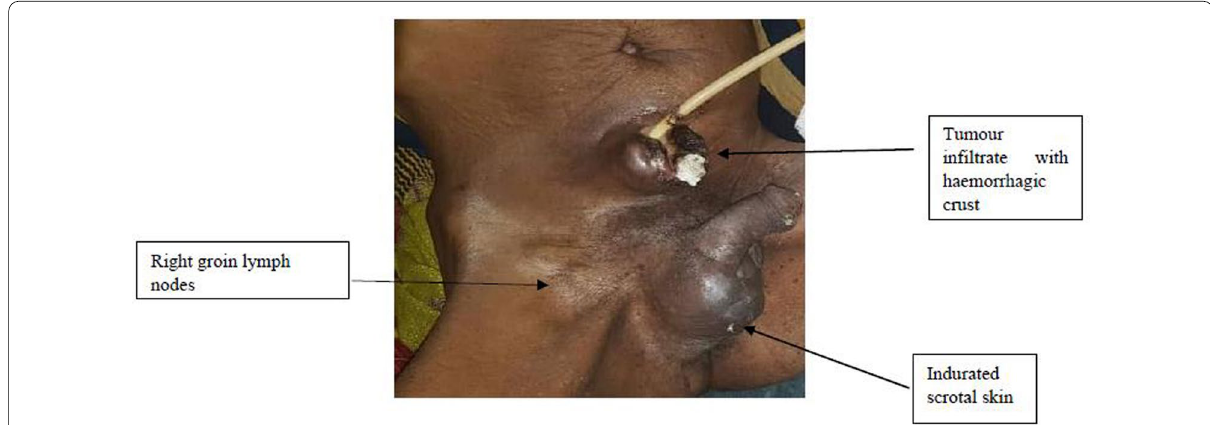
Fig. 5 Progression of disease two years following initial